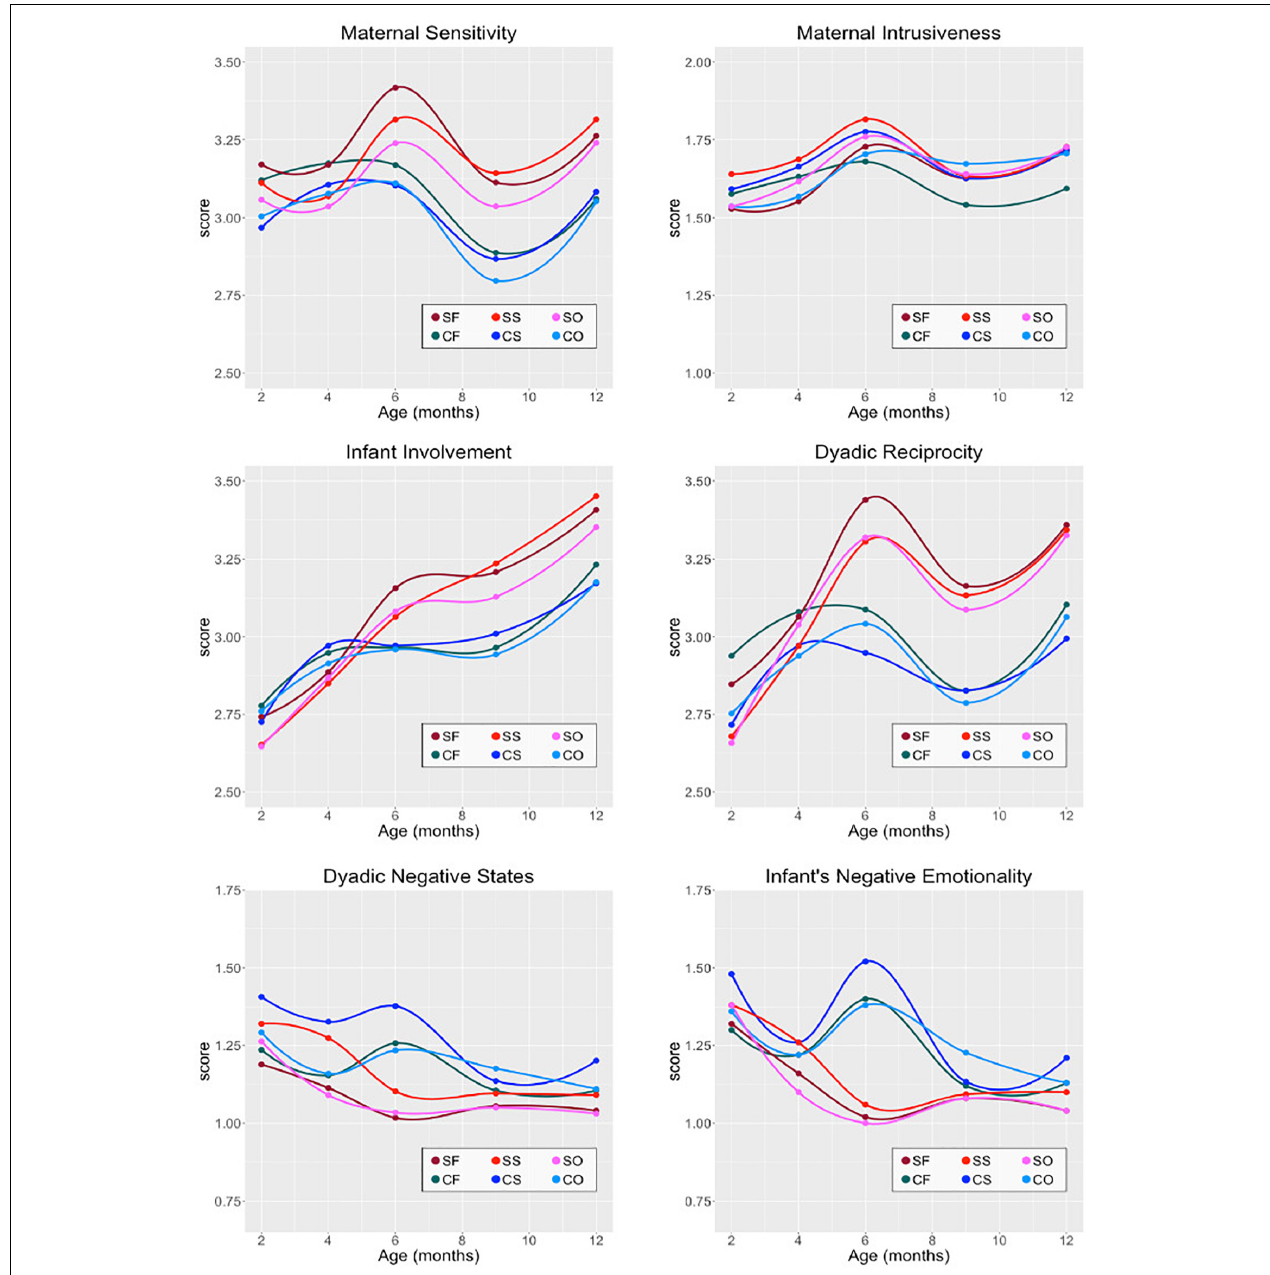
FIGURE 2 | Temporal evolution of Maternal Sensitivity, Maternal Intrusiveness, Infant Involvement, Dyadic Reciprocity, Dyadic Negative States, and Infant’s Negative Emotionality. SF, study group/Free; SS, study group/Song; SO, study group/Object; CF, control group/Free; CS, control group/Song; CO, control